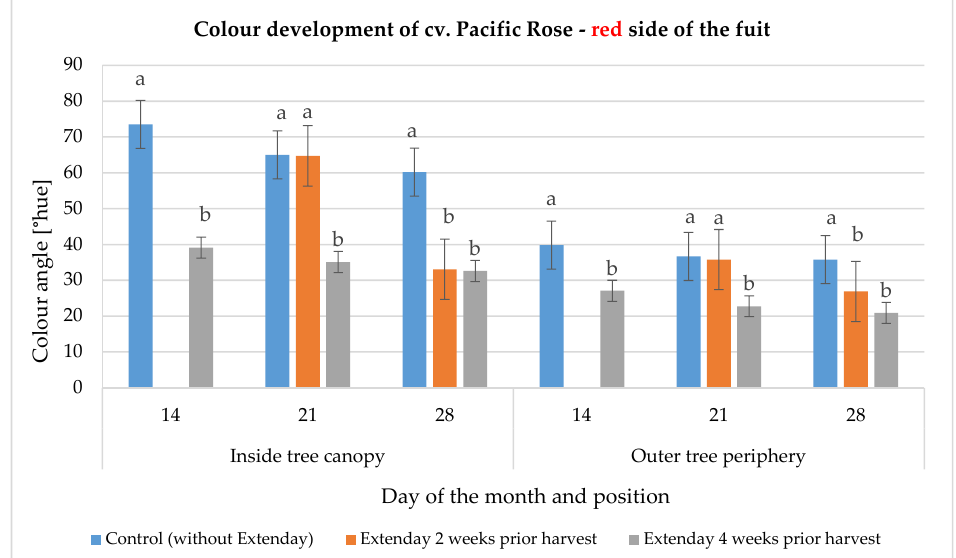
Figure 10. Colour development dependent on fruit position within the tree of cv. Pacific Rose as measured on 14, 21 and 28 March on the red side of the fruit as affected by reflective mulch. (Treatments with different letter for the same position of the fruit within the same day are statistically different ( p < 0.05) (n = 60 fruit per treatment per position).